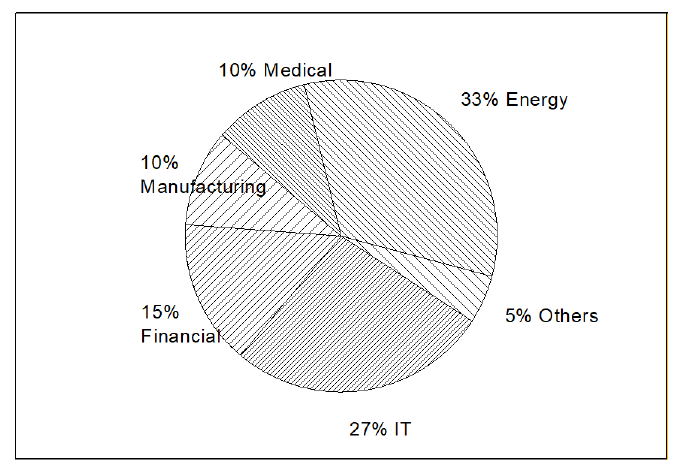
Figure 9. Distribution of all the business scopes for 172 companies.